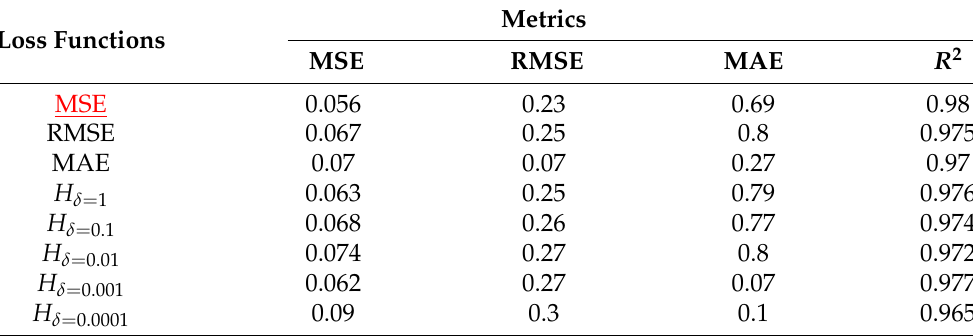
Table 12. Performance of the models using different loss functions for Loc.